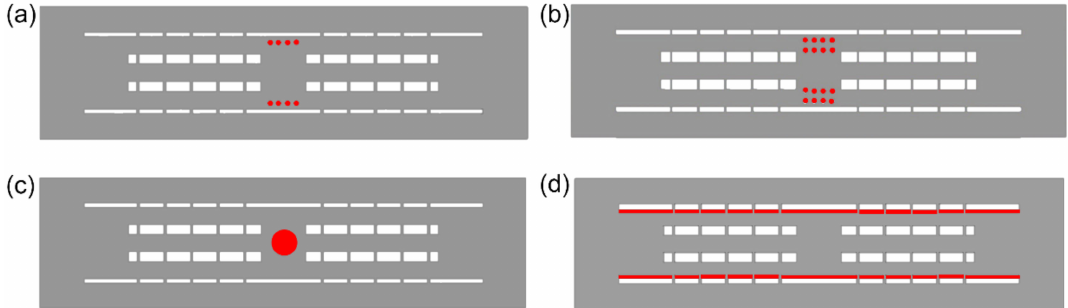
Figure 2. Different types of drug release systems: ( a ) single-layer microsphere system; ( b ) double- layer microsphere system; ( c ) bulk hydrogel system; ( d ) hydrogel film system (grey: fluid region; red: drug release system; white: wall